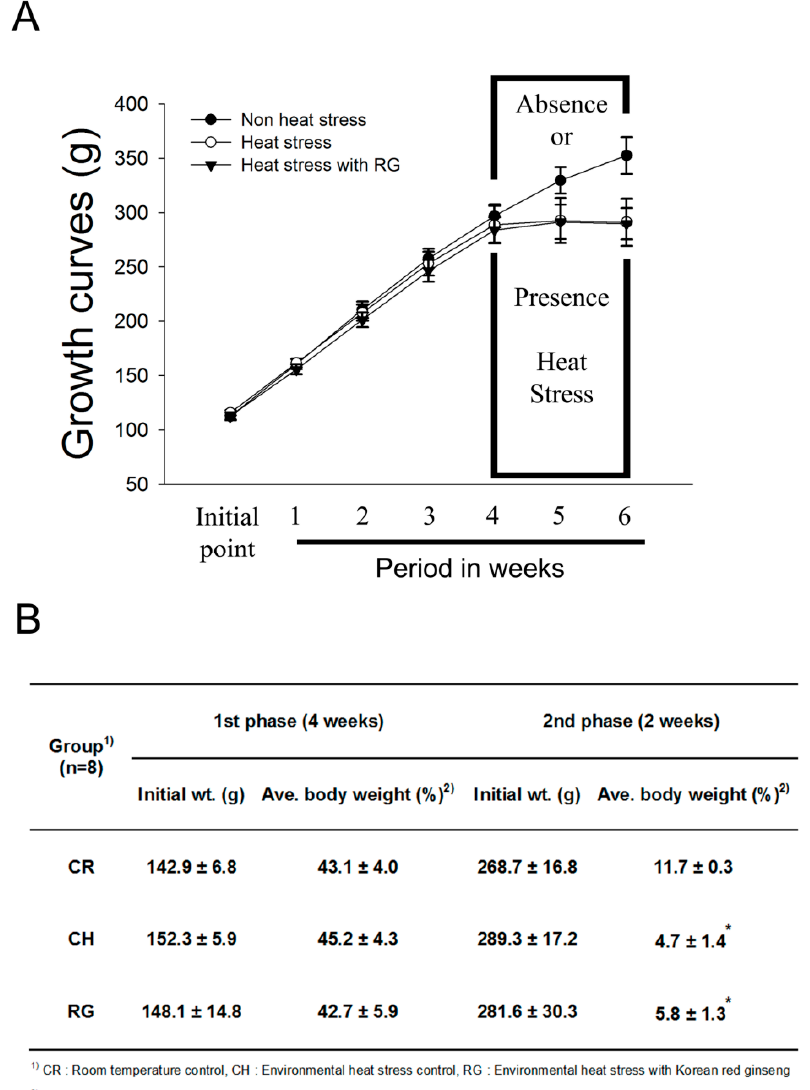
Figure 2. Growth rate for SD rats exposed to heat stress with and without RG for six weeks. ( A ) Effect of red ginseng on growth rates of the environmental heat stress exposed SD rats; ( B ) Mean of body weight change of SD rats housed under a room temperature for 4 weeks and with environmental heat stress with red ginseng (RG). Data represent the means ± standard deviation ( n = 10). * p < 0.05 compared with room temperature control.